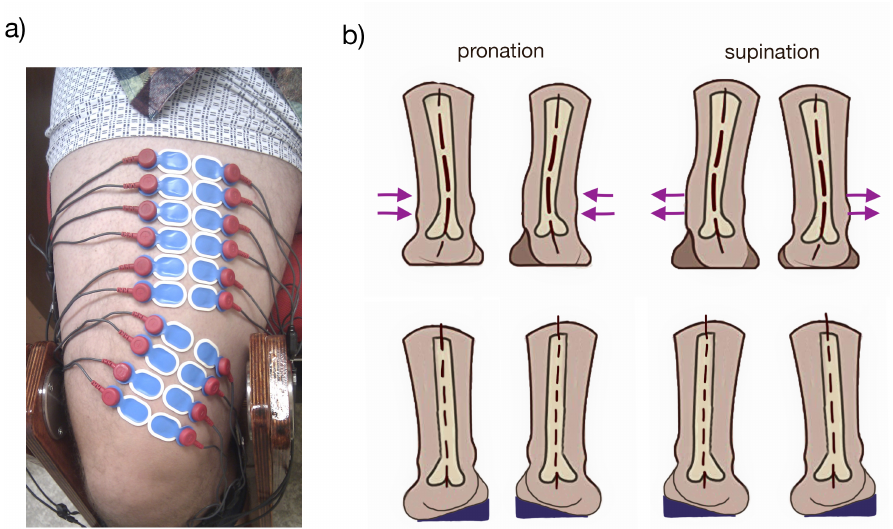
Figure 1. ( a ) Bipolar connection of electrodes and its placement on the muscle vastus medialis and rectus femoris. ( b ) Pronation and supination of the ankle and the example how to use the heel pad.